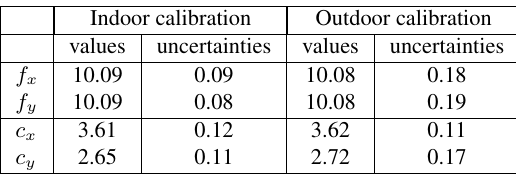
Table 1. Comparison of the SR4500 intrinsic parameters in mm between indoor and outdoor